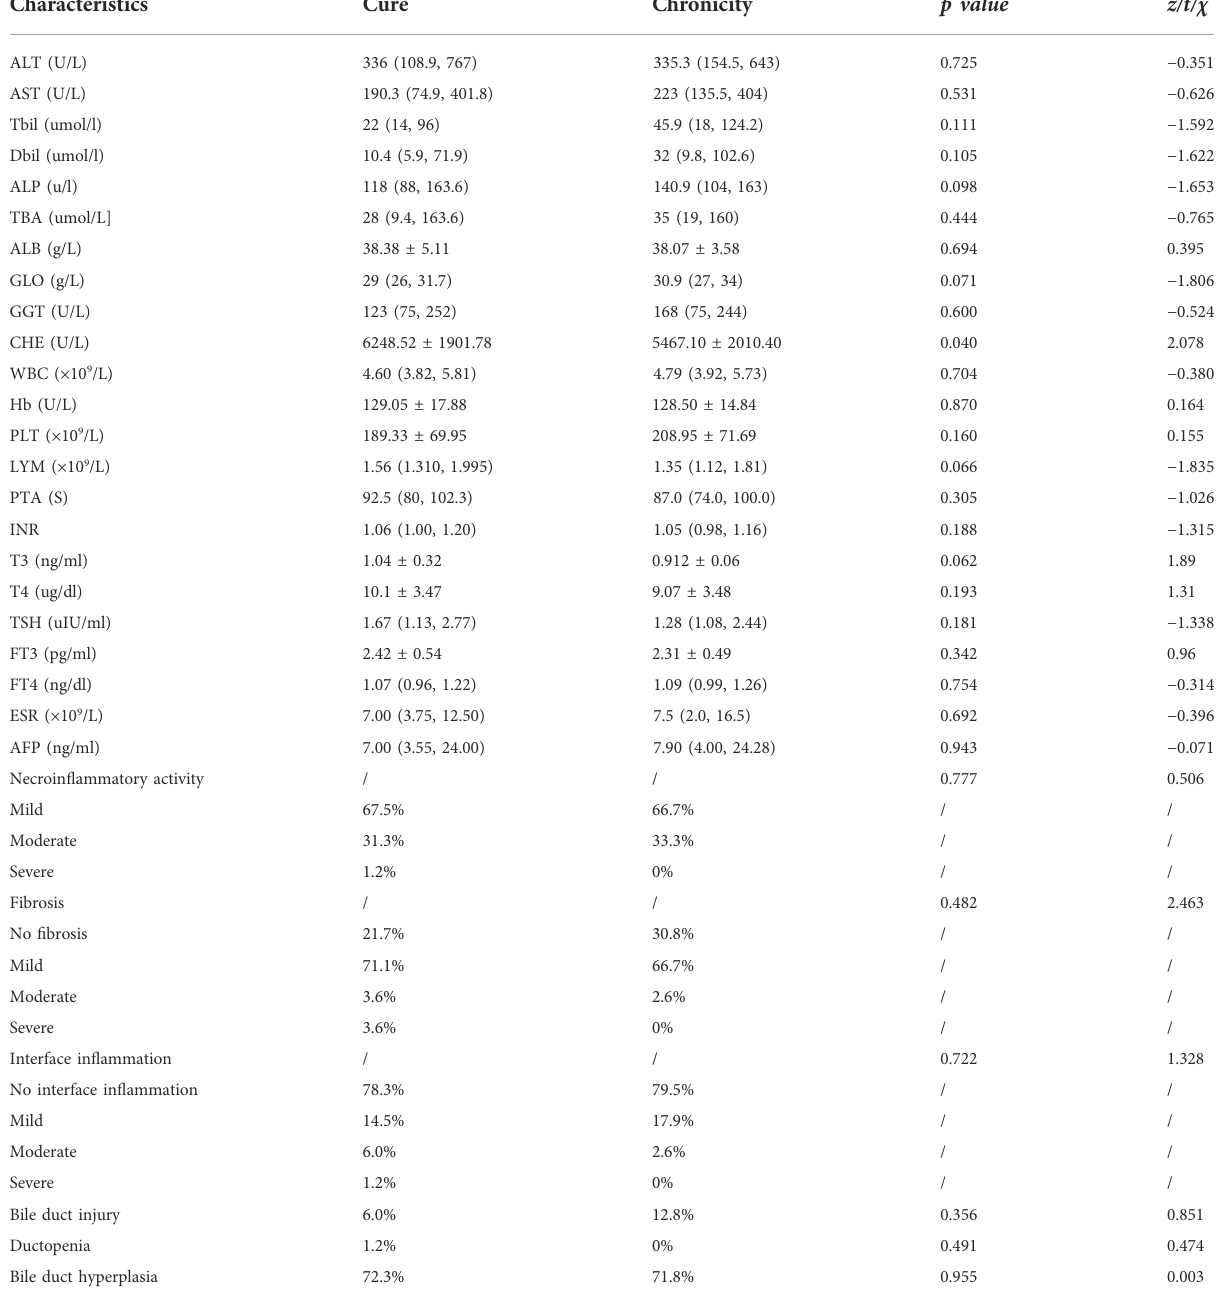
TABLE 1 Comparison of selected characteristics of baseline due to different prognosis.